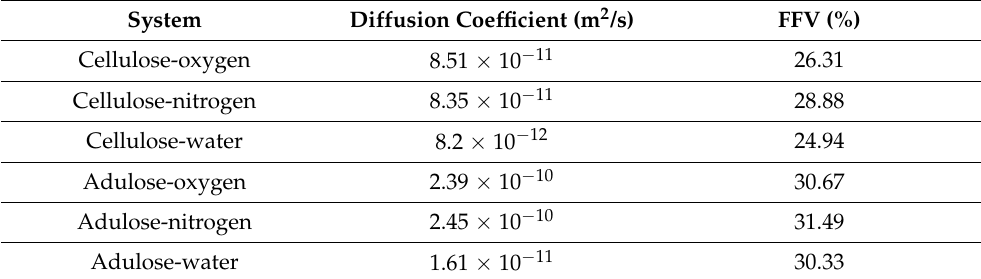
Table 2. Diffusion coefficients and FFV for oxygen, nitrogen, and water in cellulose and adulose.